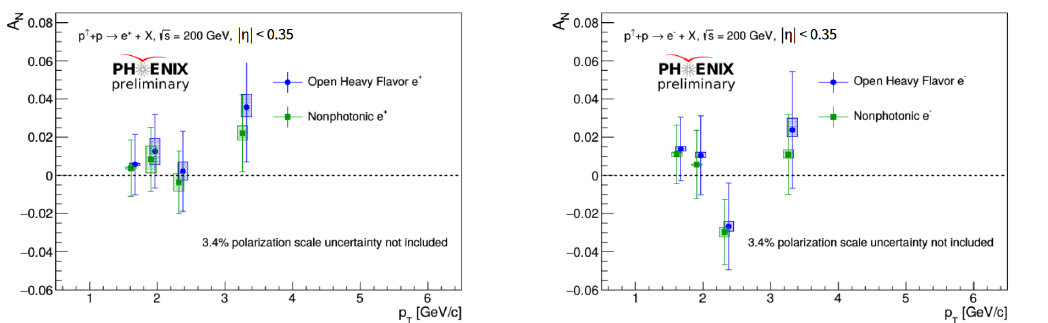
( p ) (blue), nonphotonic e + A N T ( p ) (blue), nonphotonic e − A N T